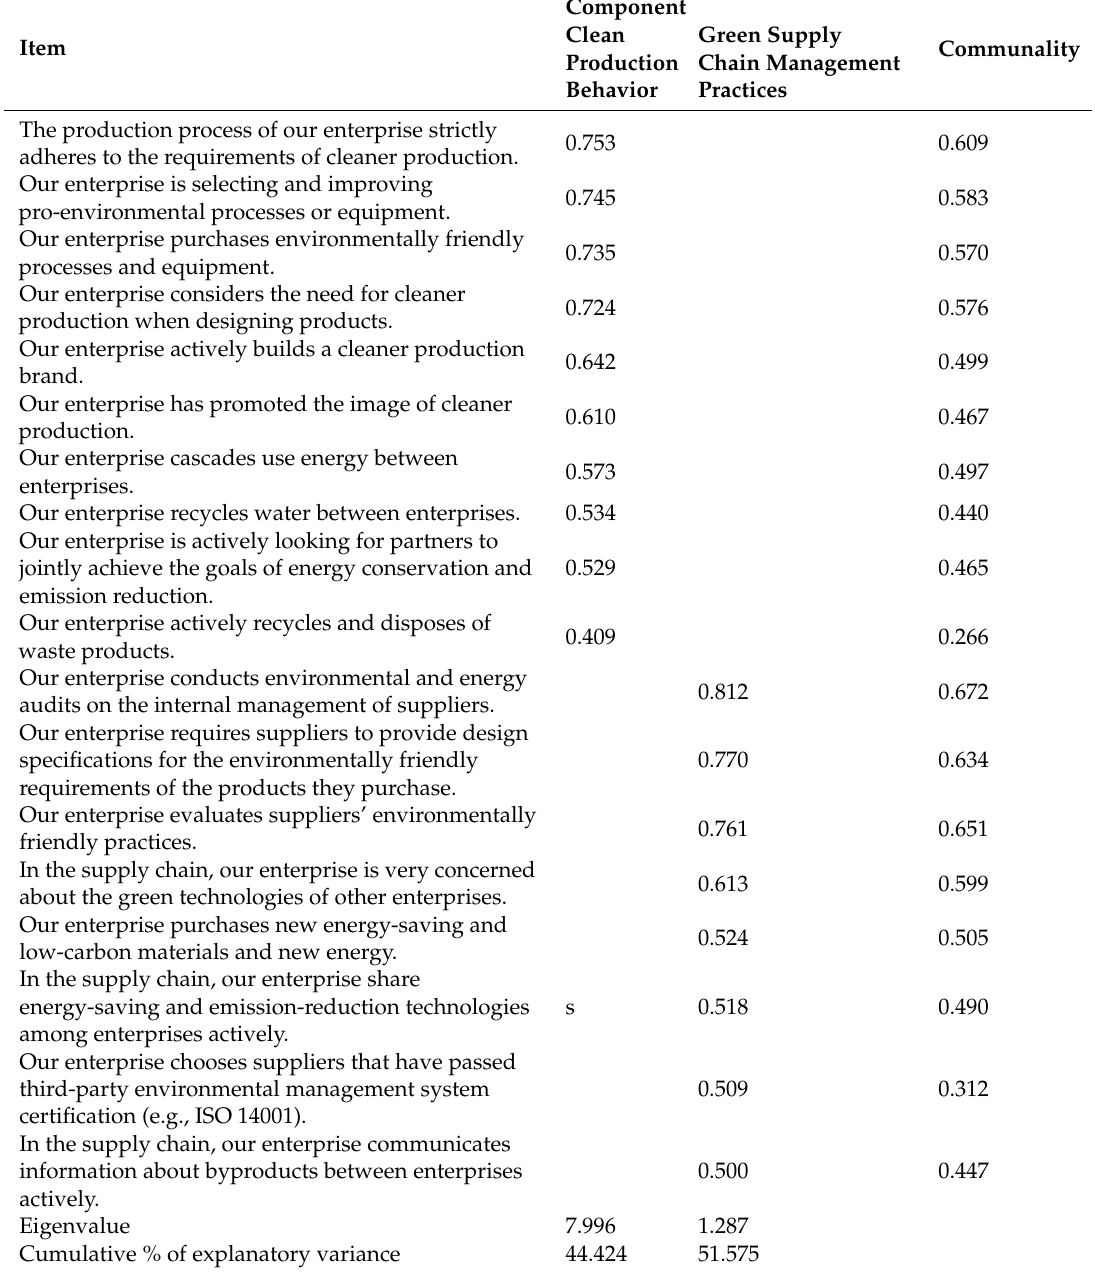
Table 8. Component and factor loadings of the GDB-IE sub-scale ( N =